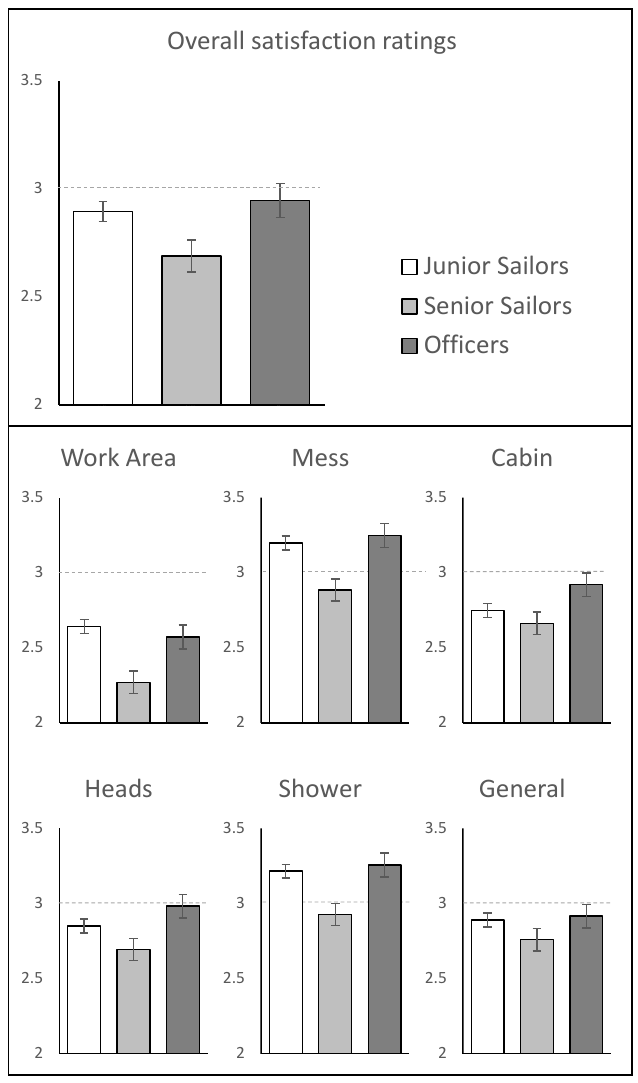
Figure 4. Mean rating scores for each rank group on overall ratings and each of the submarine areas. Ratings below the dashed line (neutral) indicate dissatisfaction, and scores above indicate satisfaction. Error bars show the standard error of the mean.